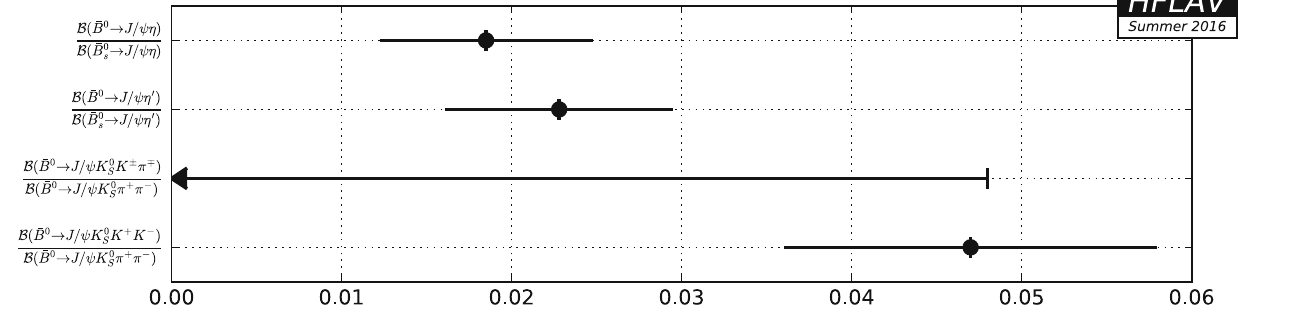
Fig. 97 Summary of the averages from Table 123